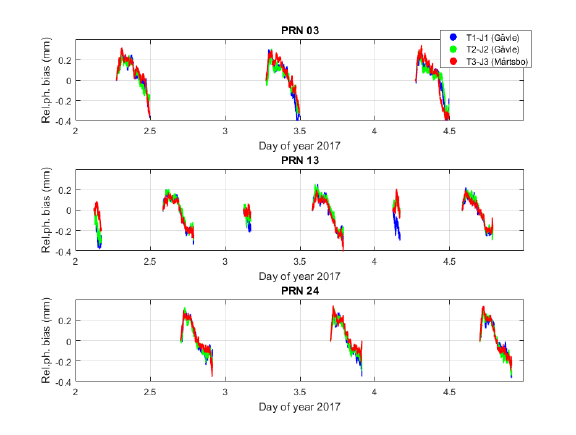
Figure 9: Temporal variations for 3 GPS satellites for the receiver combination Trimble-Javad at Gävle and